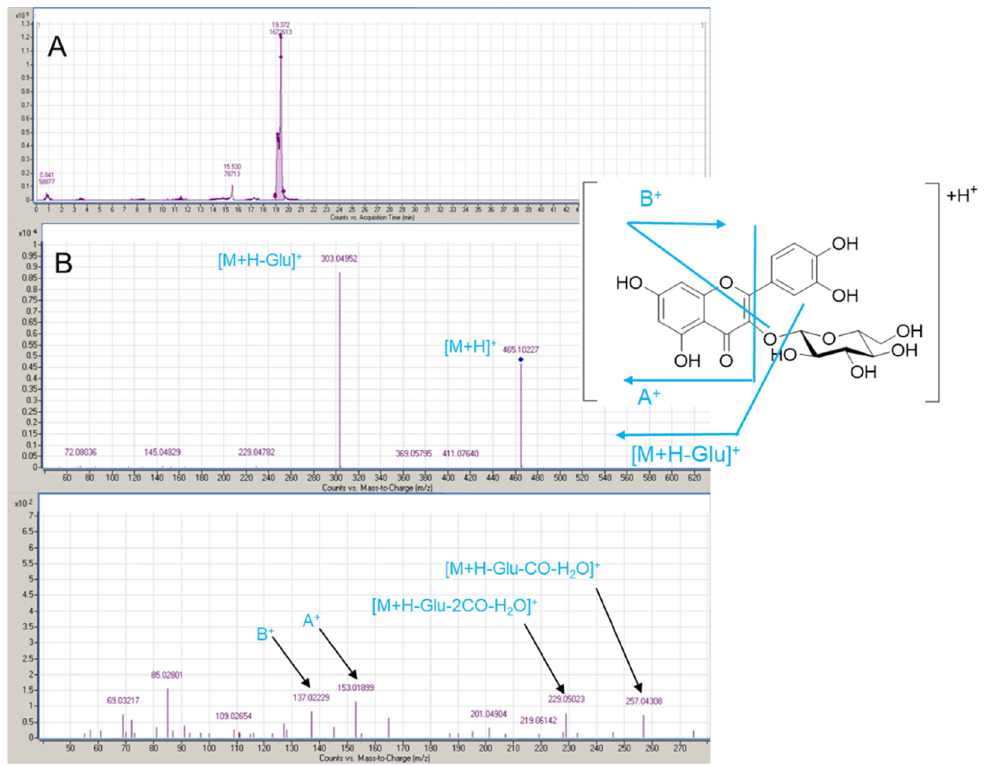
Figure 4. LC-MS/MS analysis of the peak at lower retention time of GLY/L-Pro + 30% added water sample. ( A ): LC chromatogram; ( B ): MS and MS/MS fragmentations of the peak at 19 min retention time.